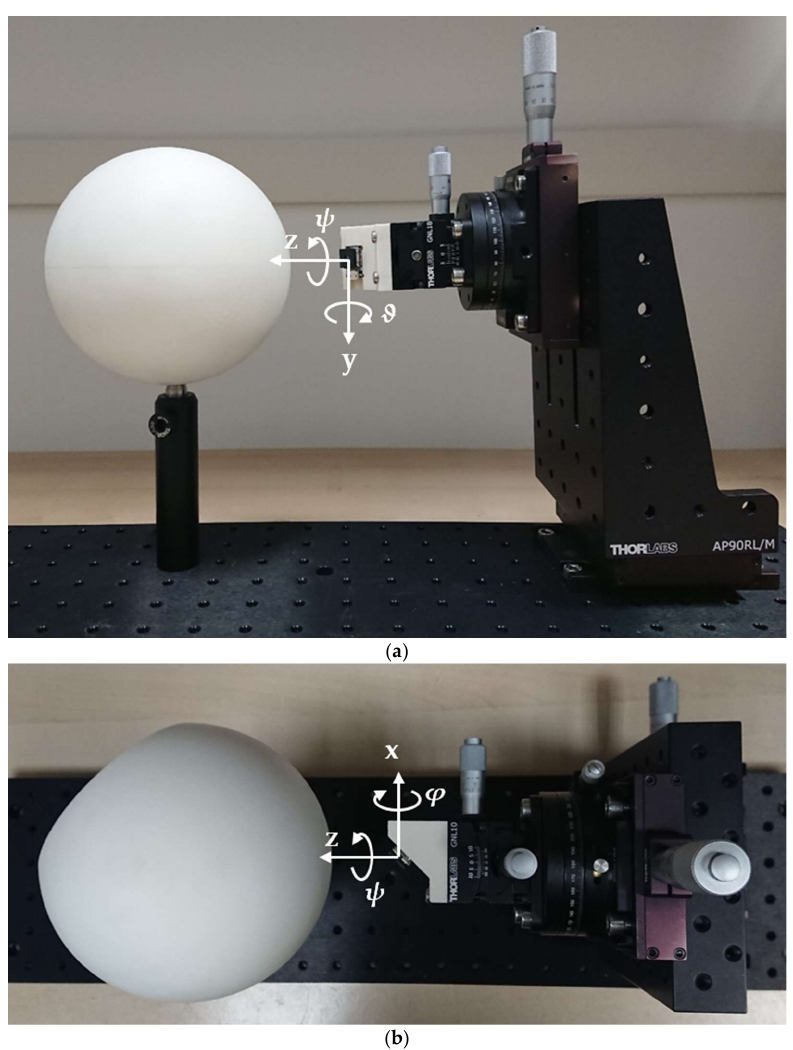
Figure 4. ( a ) Experimental testbed (side-view). ( b ) Experimental testbed (top-view).